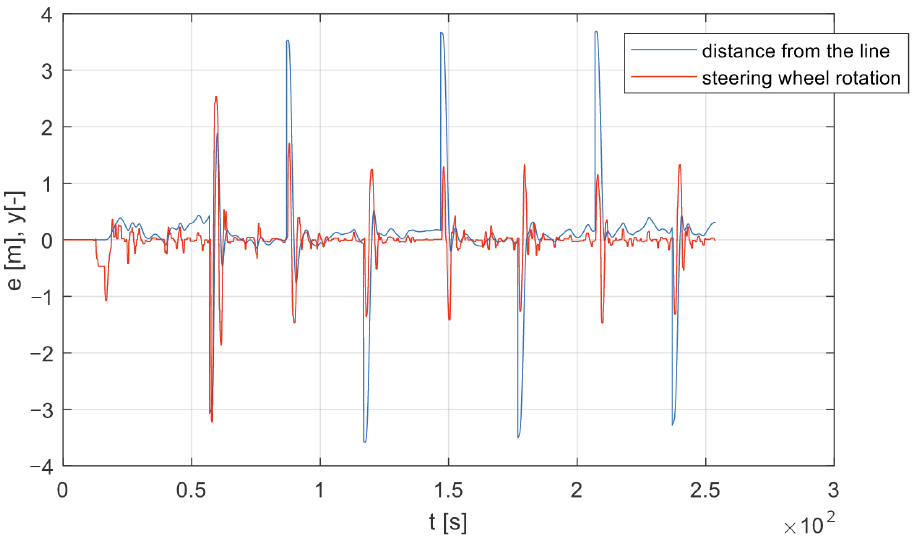
Figure 9. Measured data from VDS: the steering wheel angle and distance from the